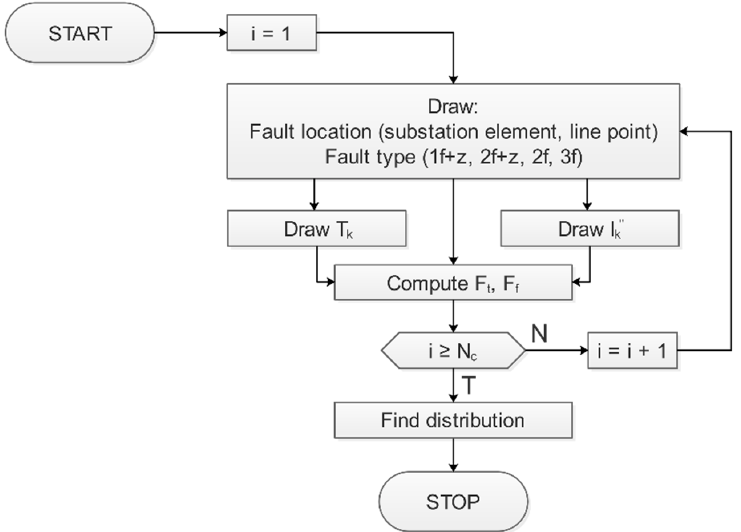
Figure 2. Scheme of finding distributions of dynamic forces F t and F f in the actual span of the substation using the Monte Carlo simulation (Adapted with permission from [14], Piechocki, P. Frackowiak, R., Eksploatacja i Niezawodno´s´c - Maintenance and Reliability, Polish Maintenance Society,